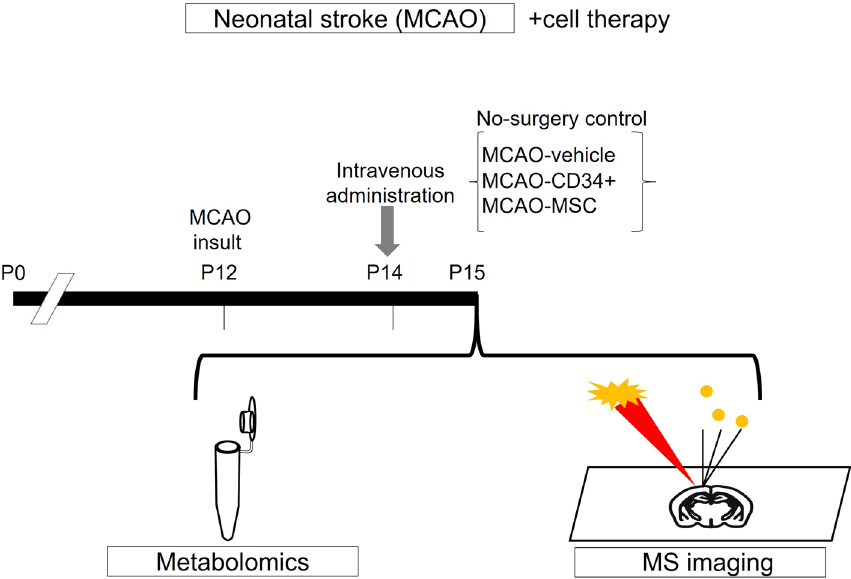
Figure 1. The experimental scheme. On postnatal day 12 (P12), mice underwent permanent middle cerebral artery occlusion (MCAO). Two days after the injury (P14), they were administered vehicle, umbilical-cord- blood-derived CD34 + cells (CD34 + ), or umbilical-cord-derived mesenchymal stem/stromal cells (MSCs) intravenously (i.v.). At P15, brain samples were collected. For metabolomic analysis, brain extracts from the injured hemispheres were analyzed by CE-TOF MS, and coronal brain sections from another cohort of mice were subjected to MS imaging.